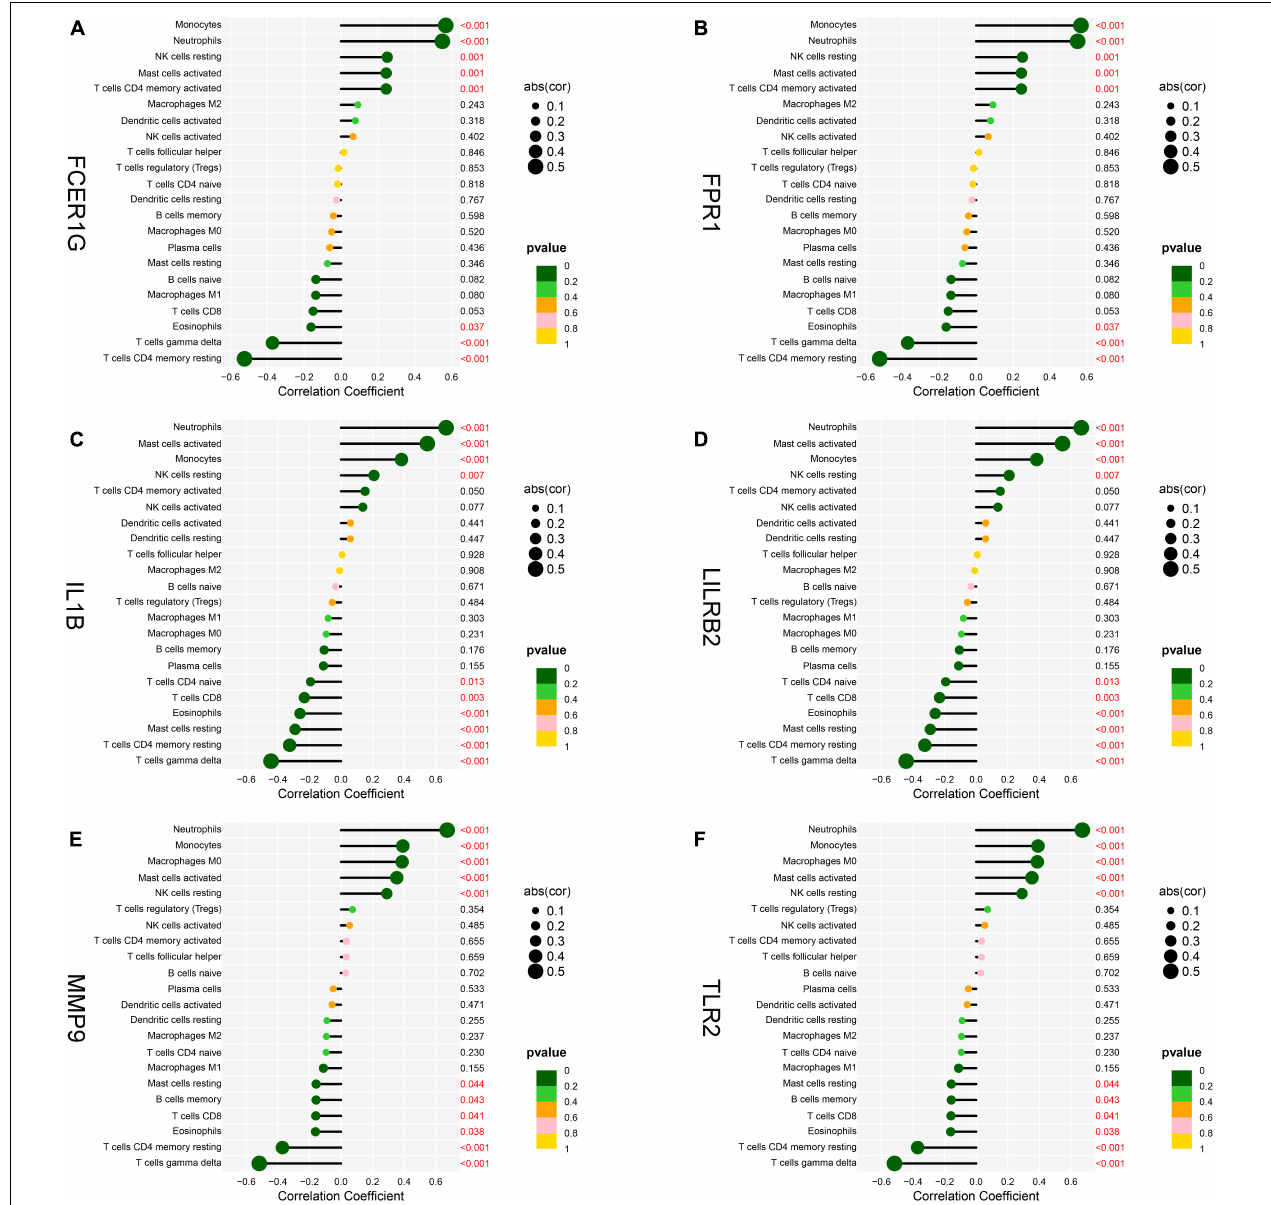
FIGURE 12 | Analysis of correlation between hub genes and immune cells. (A) FCER1G, (B) FPR1, (C) IL1B, (D) LILRB2, (E) MMP9, and (F)